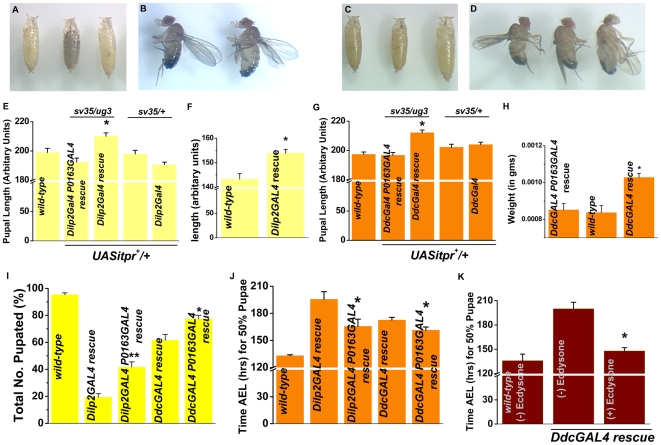
Delayed pupation in Dilp2GAL4 and DdcGAL4 rescue conditions results in larger body size.(A) From left to right: UASitpr+/+;Dilp2GAL4/+; P0163GAL4,itprsv35/ug3 (Dilp2GAL4 P0163GAL4 rescue), wild-type (Canton-S) and UASitpr+/+;Dilp2GAL4/+;itprsv35/ug3 (Dilp2GAL4 rescue) pupae. (E) Only UASitpr+ expression with Dilp2GAL4 in itprsv35/ug3 background causes a significant increase (*p<0.005; Student's t-test) in pupal length as compared to controls of all the indicated genotypes. Pupal length is restored close to wild-type in Dilp2GAL4::P0163GAL4 rescue condition. (B) From left to right: wild-type and Dilp2GAL4 rescued flies. (F) Body length of Dilp2GAL4 rescued flies is significantly more than wild-type flies (*p<0.05; Student's t-test). (C, D) From left to right: UASitpr+/+;DdcGAL4/+;P0163GAL4,itprsv35/ug3 (DdcGAL4 P0163GAL4 rescue), wild-type (Canton-S) and UASitpr+/+;DdcGAL4/+;itprsv35/ug3 (DdcGAL4 rescue) pupae (C) and flies (D). (G) Only UASitpr+ expression with DdcGAL4 in itprsv35/ug3 background causes a significant increase (*p<0.005; Student's t-test) in pupal length as compared to controls of all the indicated genotypes. Pupal length (G) and adult weight per fly (H) is increased in the DdcGAL4 rescued condition (*p<0.005; Student's t-test) but is restored close to wild-type in DdcGAL4::P0163GAL4 rescue condition. n = 10 or more for each individual genotype for (A–G). For (H), the following numbers of male flies (n) in batches of around 3 flies each were weighed for each genotype: DdcGAL4 P0163GAL4 rescue n = 26, wild-type n = 30 and DdcGAL4 rescue n = 54. (I) Total number of larvae that undergo pupation is significantly increased on introducing a prothoracic gland GAL4 (P0163GAL4) in DdcGAL4 and Dilp2GAL4 rescued conditions (*p<0.05, **p<0.005; Student's t-test). (J) Time AEL for 50% pupal formation is significantly reduced with P0163GAL4 in DdcGAL4 and Dilp2GAL4 rescued conditions (*p<0.005; Student's t-test). However the 50% pupation time in all single and double GAL4 conditions remained longer than the 50% pupation time of wild-type. For (I) and (J) 25 larvae in the following number of batches (N) were assayed for pupation for each genotype: wild-type N = 11, Dilp2GAL4 rescue N = 10, Dilp2GAL4 P0163GAL4 rescue N = 5, DdcGAL4 rescue N = 13 and DdcGAL4 P0163GAL4 rescue N = 9. (K) DdcGAL4 rescued itprsv35/ug3 larvae pupated earlier on being fed 20-hydroxyecdysone (∼150 hrs AEL) than larvae without 20-hydroxyecdysone (∼200 hrs AEL) (*p<0.05; Student's t-test). A minimum of 75 animals were screened in batches of 25 each. Differences in pupation rate are not apparent upon 20-hydroxyecdysone feeding in Dilp2GAL4 rescue animals due to increased lethality in this condition in late third instar larvae. The DdcGAL4 rescued condition which were not fed ecdysone, pupated at a slower rate than those observed in (J). This is very likely due to differences in culture conditions in the two cases. Results are expressed as mean±SEM.